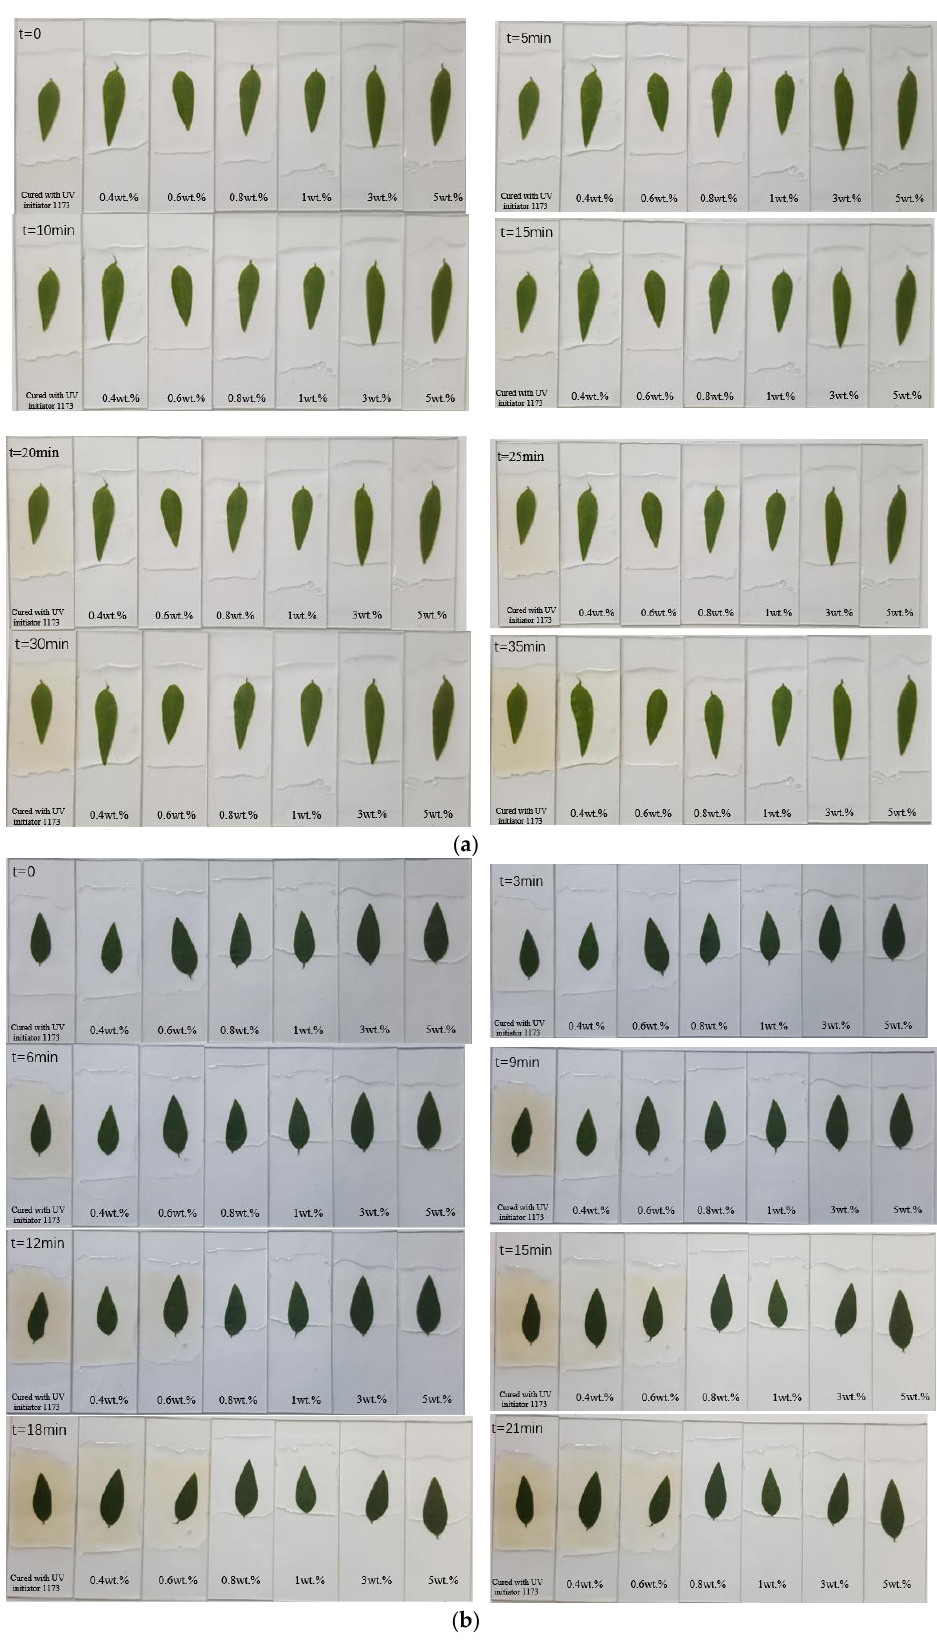
Figure 9. Photos of coatings (entries 1–7 in Table 4) before and after UV-aging. ( a ) Before and after UV–aging at room temperature; ( b ) Before and after UV–aging at 100 °C. UV–aging at room temperature; ( b ) Before and after UV–aging at 100 ◦